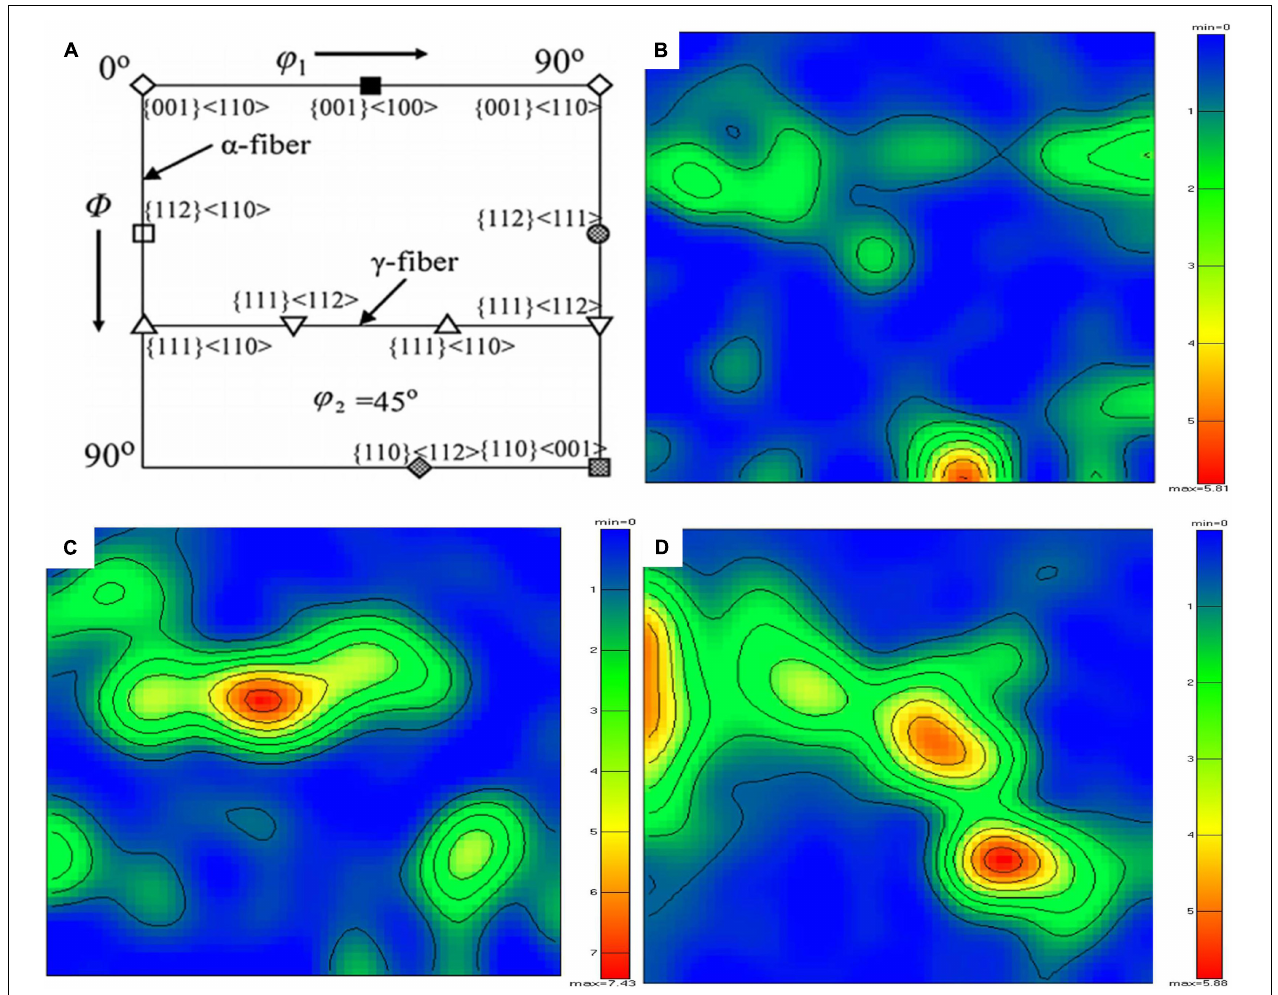
FIGURE 4 | Sections ( ϕ 2 = 45 ◦ ) of the orientation distribution functions (ODFs) on the rolling plane for the β phase of the Ti–10Mo–6Zr–4Sn–3Nb alloy: (A) schematic diagram of section ( ϕ 2 = 45 ◦ ) of the ODFs with typical texture components corresponding to the body-centered cubic metallic materials; cold swaging deformed at (B) 25%, (C) 55%, and (D)